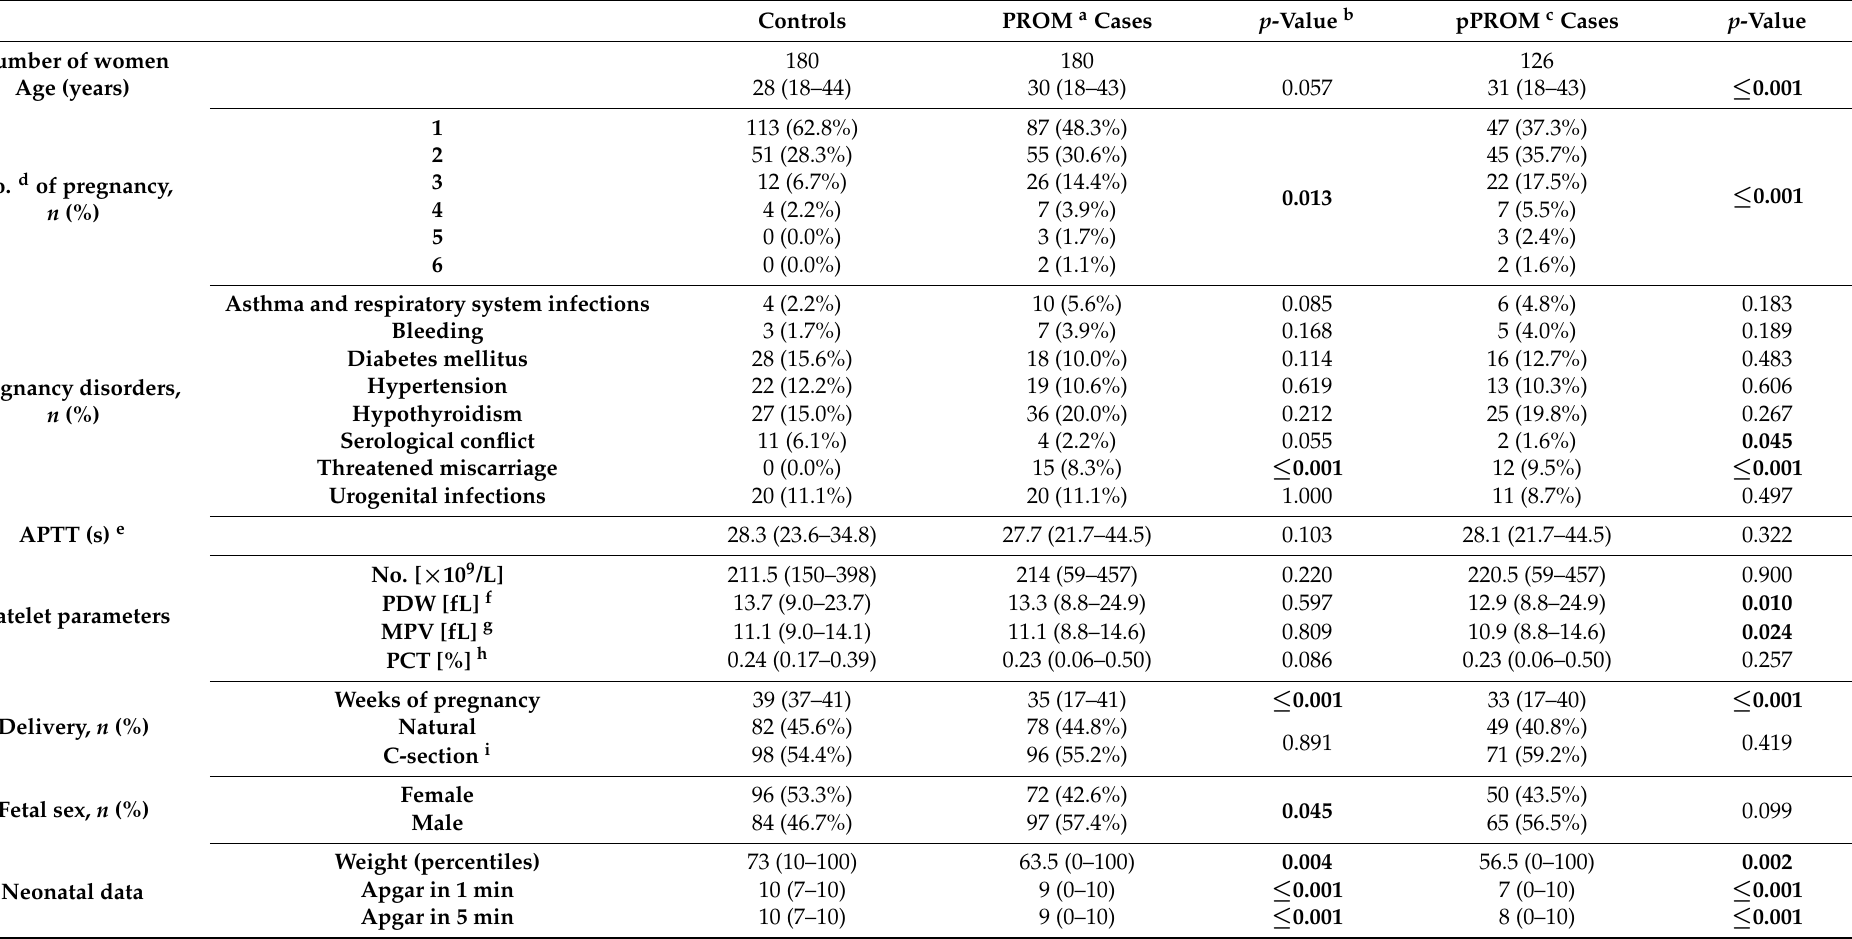
Table 1. Characteristics of women with prelabor rupture of membranes and healthy